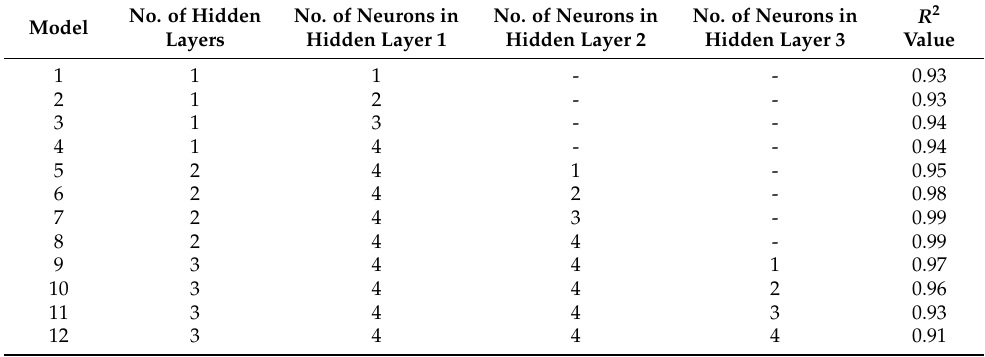
Table 4. Performances of the developed ANN models based on their coefficient of determinant.